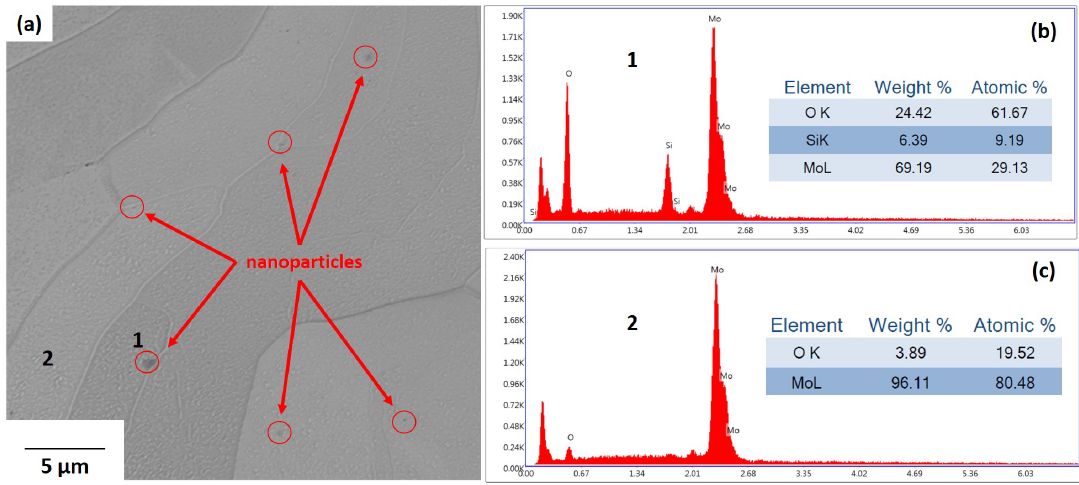
Figure 7. ( a ) Mo-0.1SiC with nanoparticle inclusions; ( b ) Nanoparticle EDS analysis result ( c ) Bulk material EDS analysis